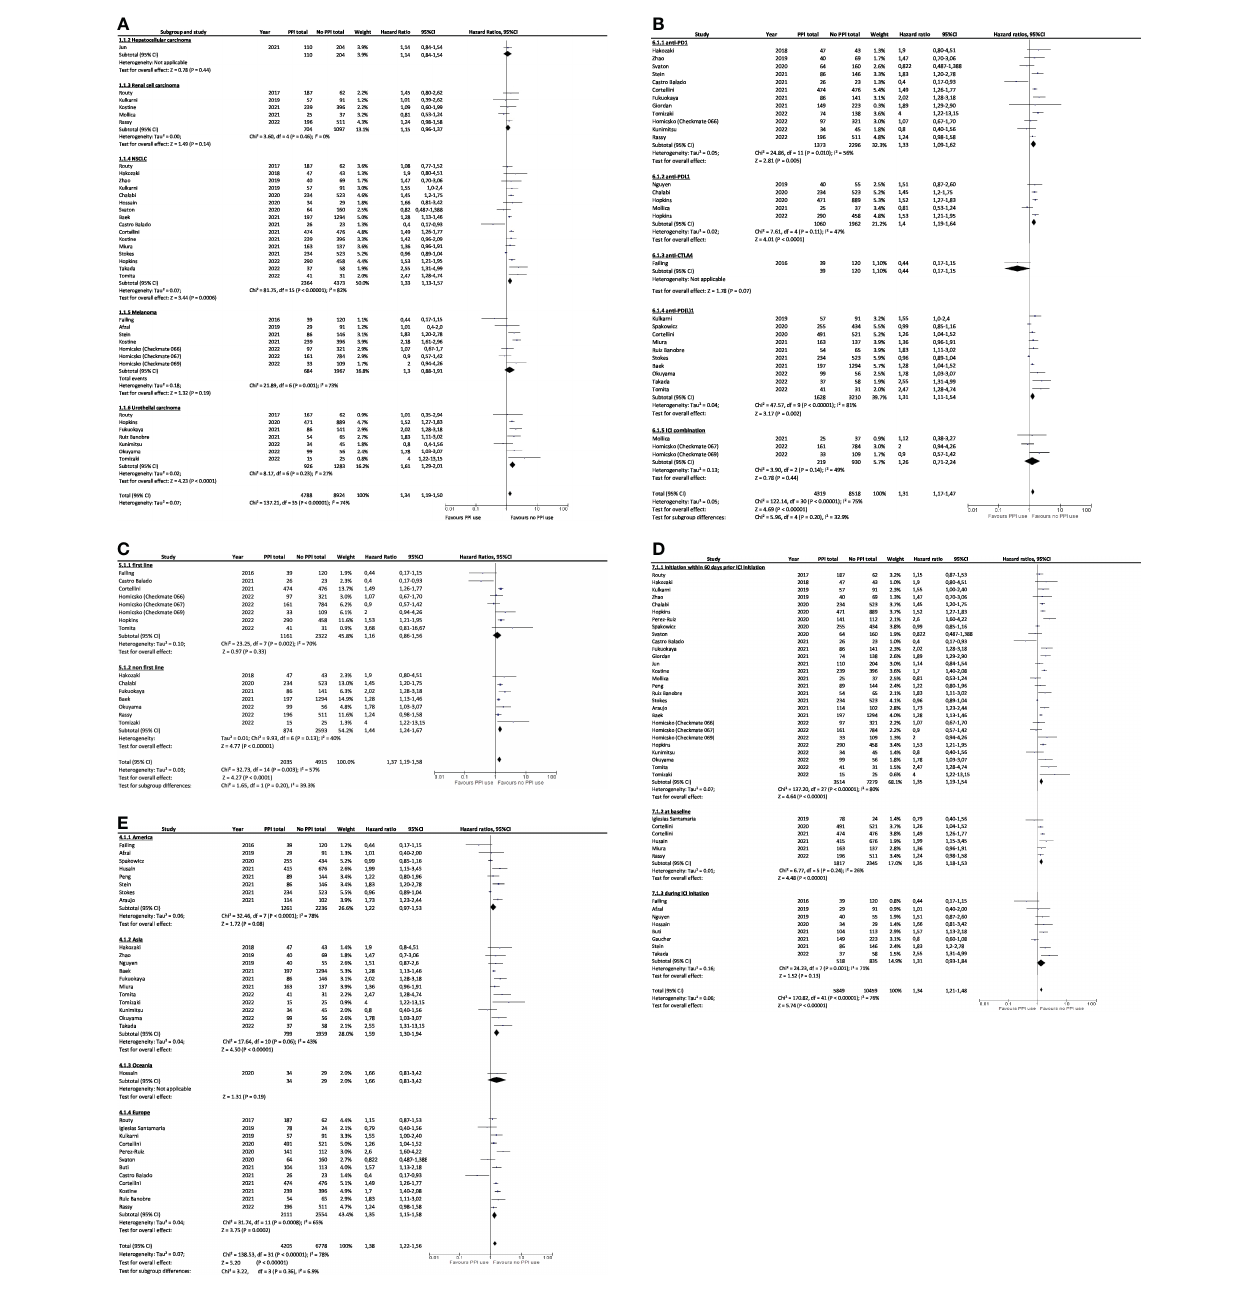
FIGURE 4 Subgroup analysis of association between PPI use and overall survival by (A) cancer type, (B) type of immunotherapy, (C) treatment line, (D) PPIs use window, and (E) continents. PPI, proton pump inhibitor; CI, con fi dence interval; NSCLC, non-small cell lung cancer; ICI, immune checkpoint